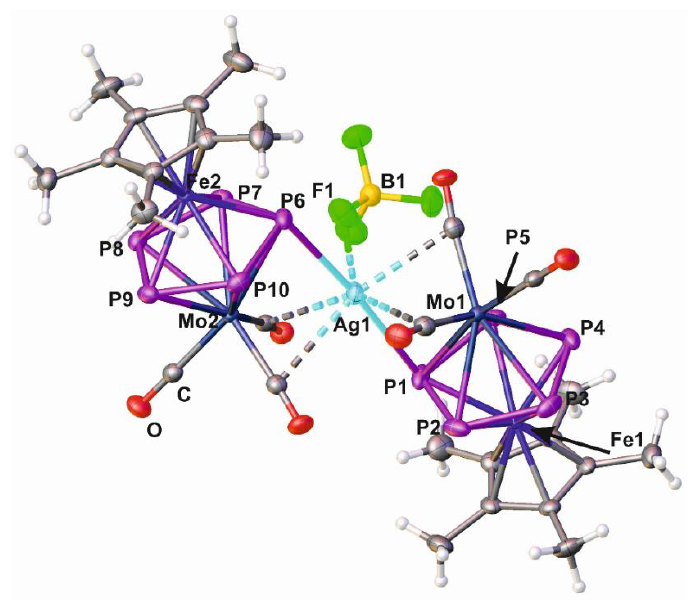
Figure 2. Molecular structure of 3 in the solid state. Selected bond lengths [Å ] and angles [°]: Ag1 – P1